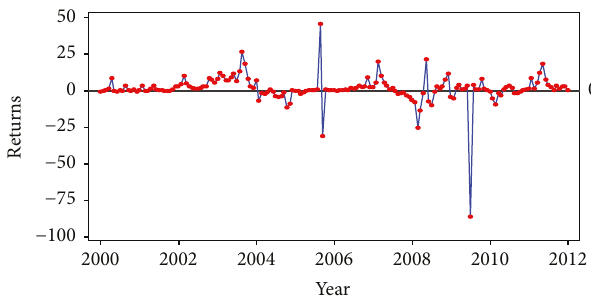
Figure 1: Time series plot of the monthly stock market returns in Ghana